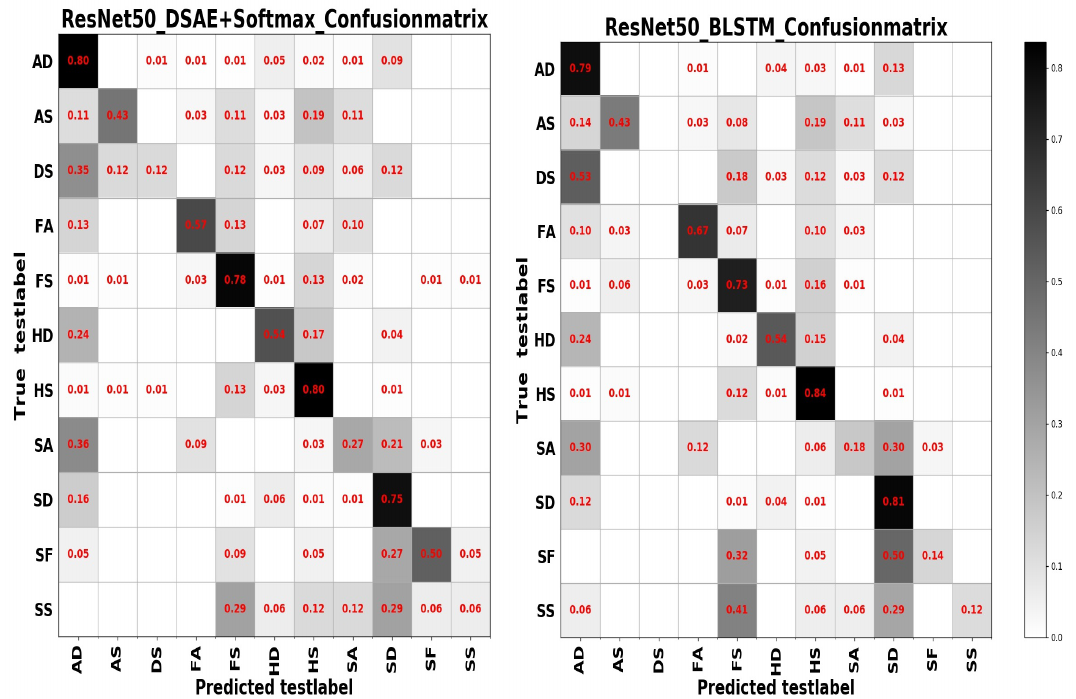
Figure 14. The confusion matrix on the RAF Compound test set for the model ensembling of ResNet50 and DSAE+Softmax ( left ); the confusion matrix on the RAF Compound test set for the model ensembling of ResNet50 and BLSTM ( right ).